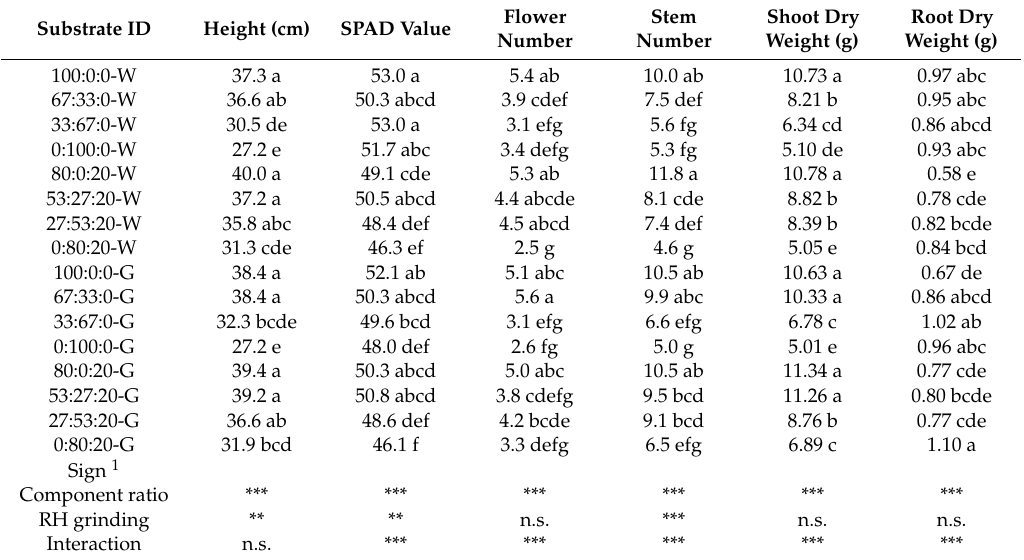
Table 4. Interaction e ff ect of component ratio and rice hulls (RH) grinding on geranium plant traits.